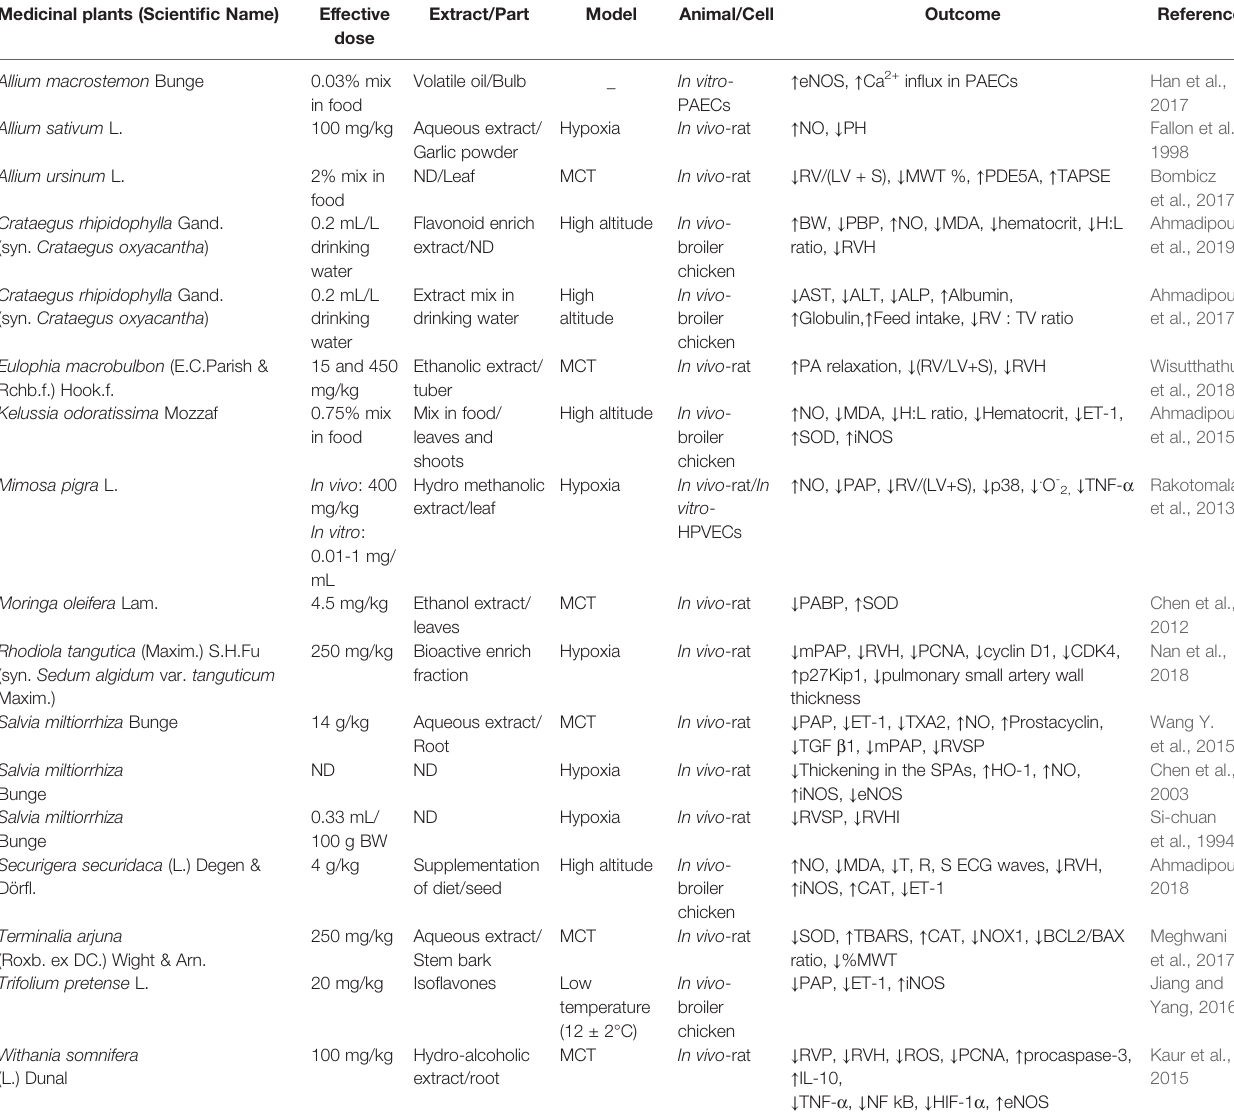
TABLE 1 | Medicinal plants used for Pulmonary Hypertension treatment. Medicinal plants (Scienti fi c